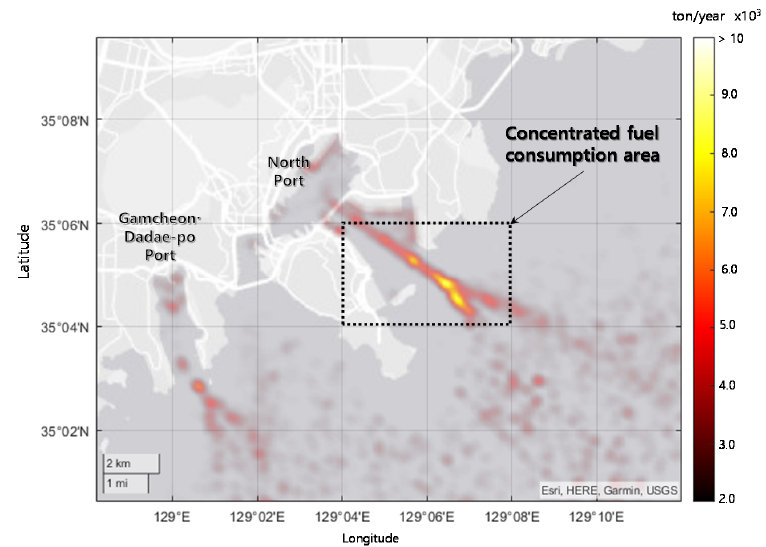
Figure 4. Area of concentrated fuel consumption in BP in 2019.